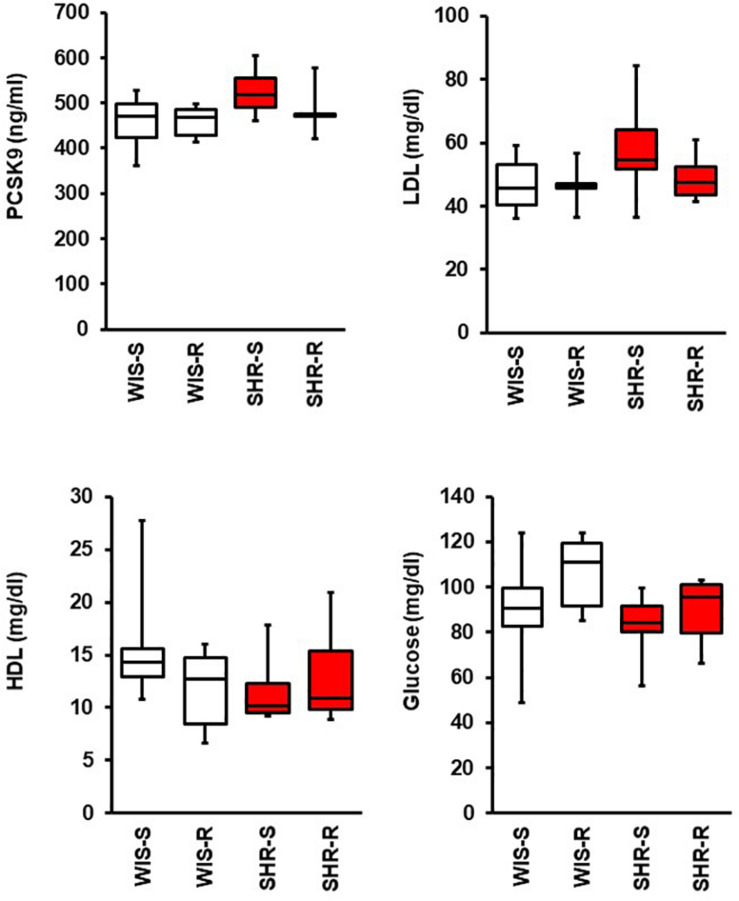
Effect of free running wheel activity (R) on plasma PCSK9, LDL, HDL, and glucose concentrations and comparison between both strains. Data are box plots representing the 25, 50, and 75% quartile and the whiskers representing the total range.